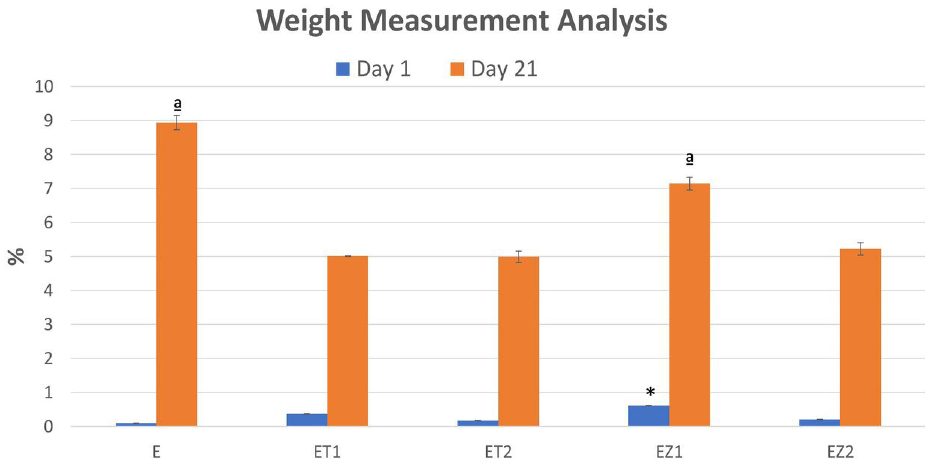
Figure 6. Graph showing mean measurement of weight change % after 1 and 21 days. * Statistically significant difference at day 1; ª significant difference than other groups